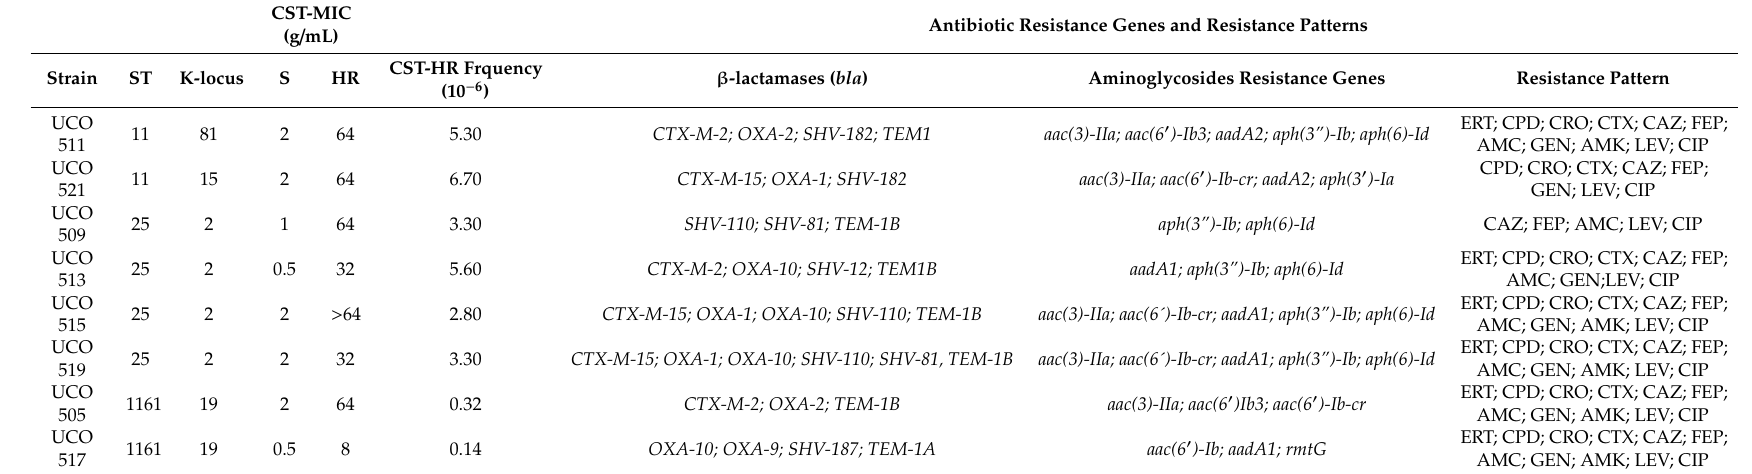
Table 2. Main characteristics of CST-HR K. pneumoniae strains ( n = 8). The table includes antibiotic-susceptibility patterns, clonal lineages, and antibiotic-resistance genes. CST-MIC (g / mL)